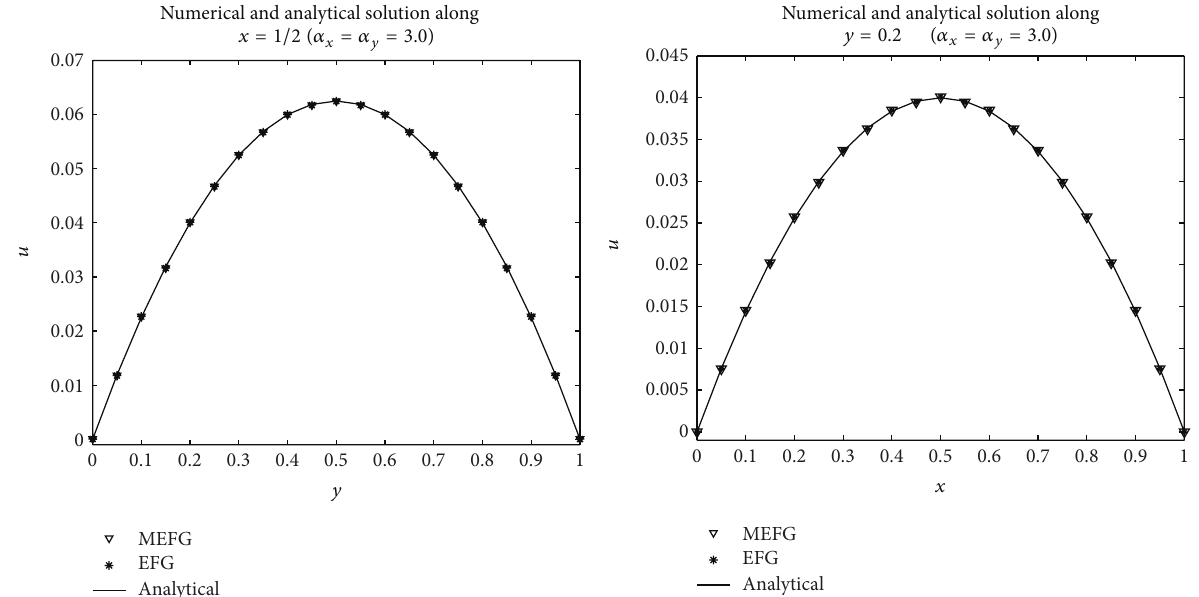
Figure 9: Comparison of analytical and numerical solution.